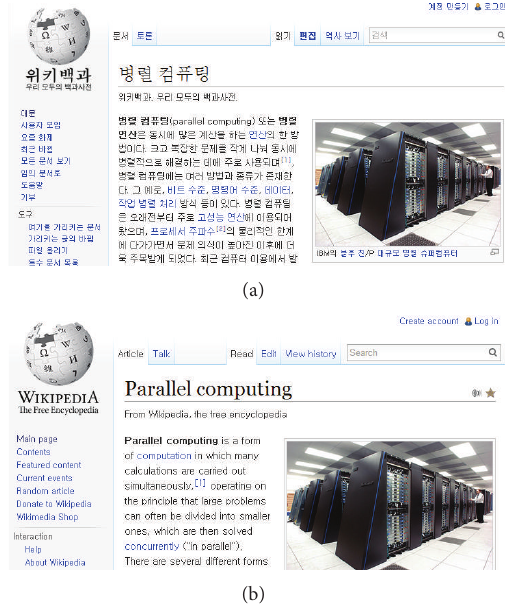
Figure 1: A join problem to insert a hyperlink from English words “parallel computing” of Korean Wikipedia pages to the correspond- ing page of English Wikipedia. (a) Korean Wikipedia (http://ko.wik- ipedia.com/) and (b) English Wikipedia (http://en.wikipedia.com/).